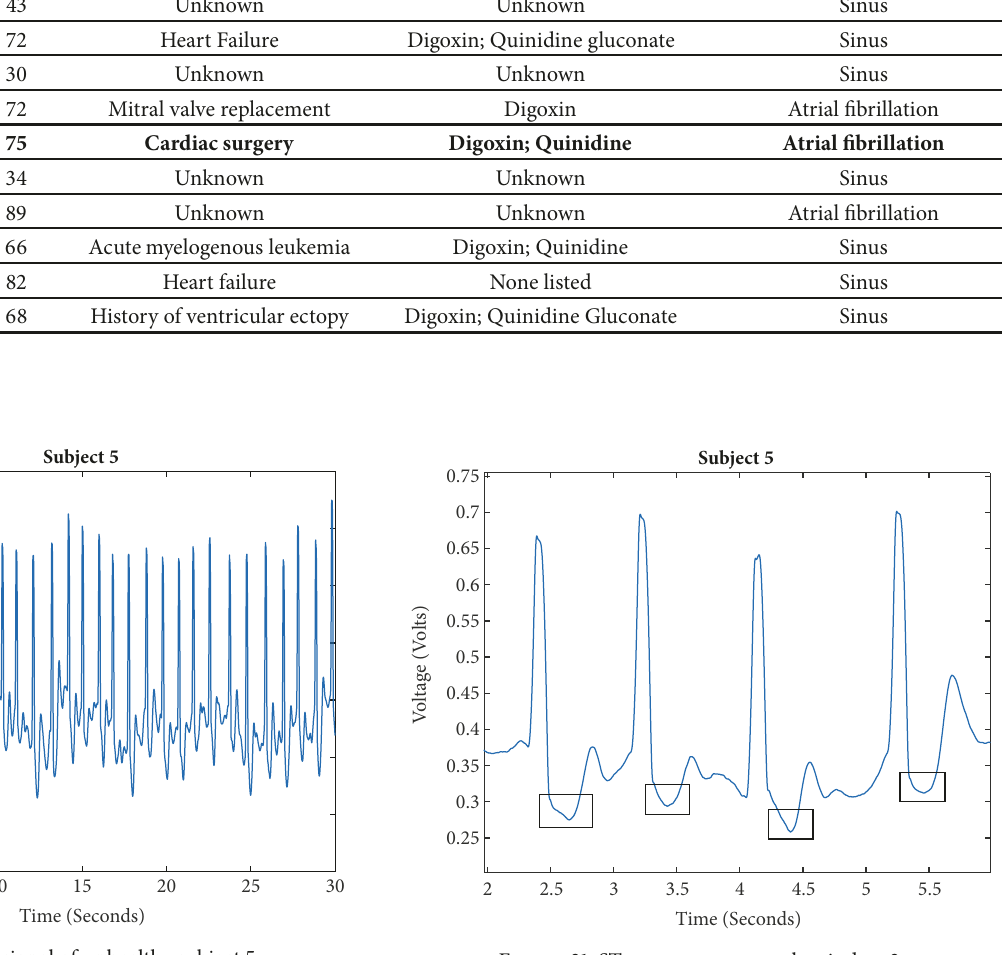
Figure 21: ST segments on sample window